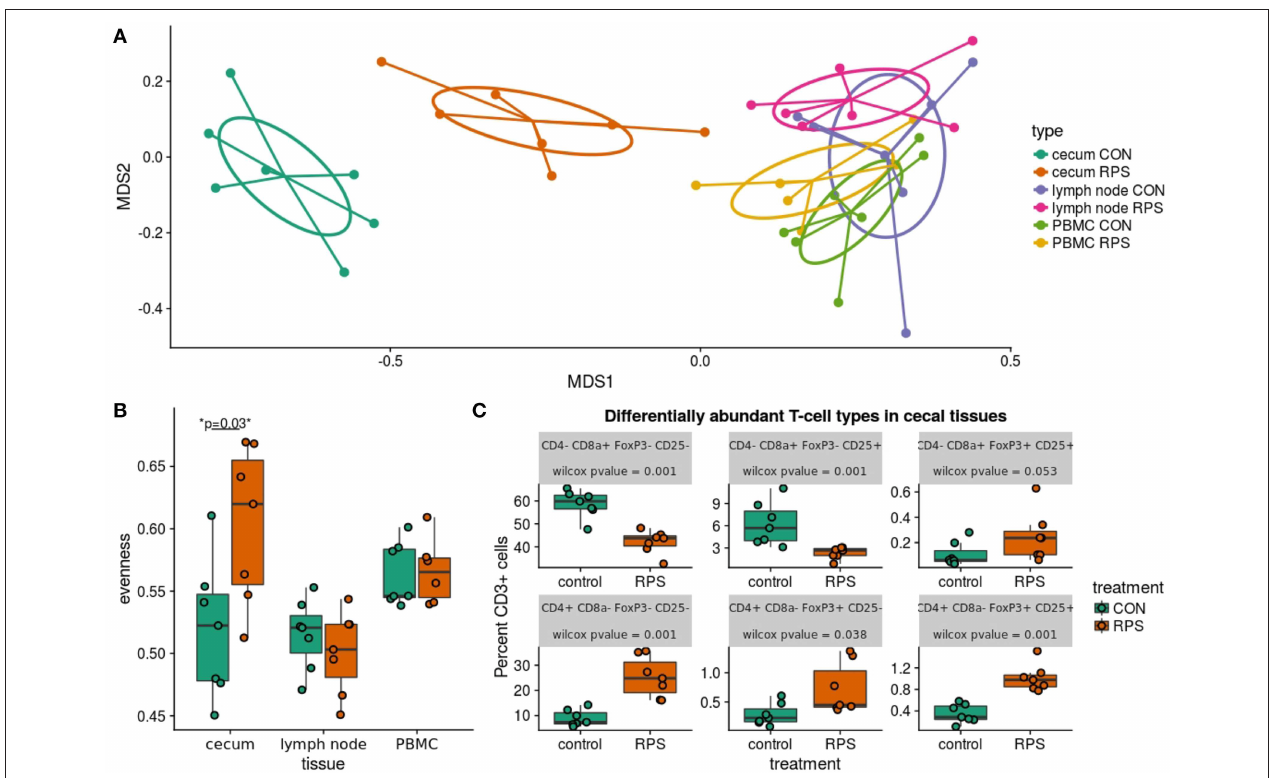
FIGURE 6 | Differences in T cell populations between the RPS and CON animals at 21 days post-weaning. (A) NMDS ordination of Bray-Curtis dissimilarities of T cell communities in various tissues. Each point represents the total T cell community for one pig in a certain tissue, and distances between points represent the similarities between communities. (B) The evenness (Pielou’s J) of the T cell communities in various tissues. Low evenness indicates that a community is dominated by a few abundant members. (C) Boxplots of significantly differentially abundant T cell types from the cecal T cell community.